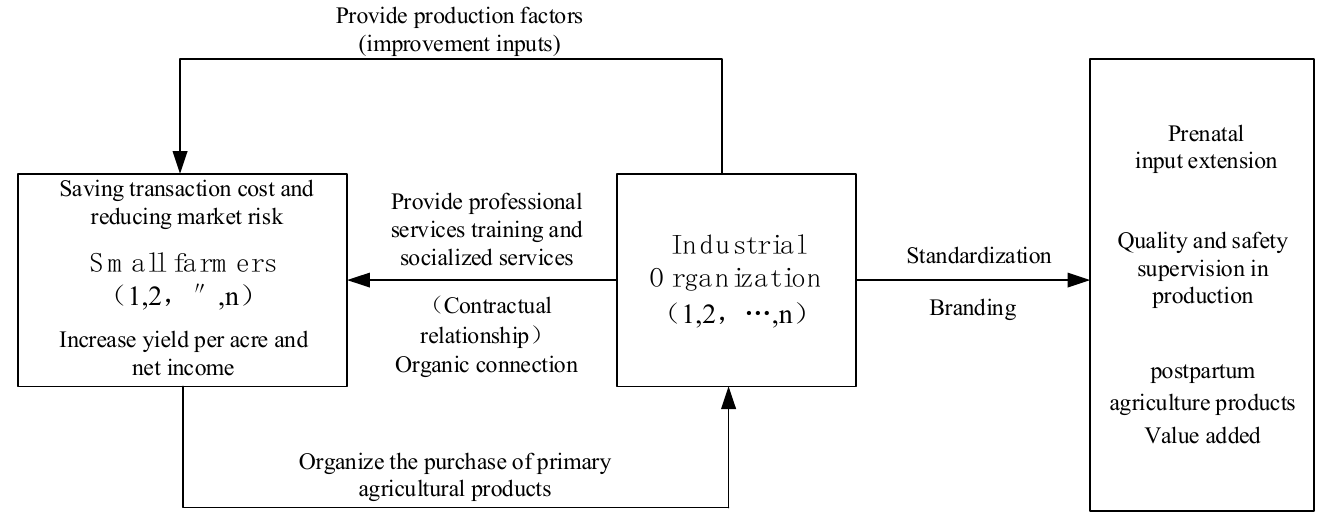
Figure 1. Mechanism of the influence of farmers’ participation in the industrial chain on their performance (original).